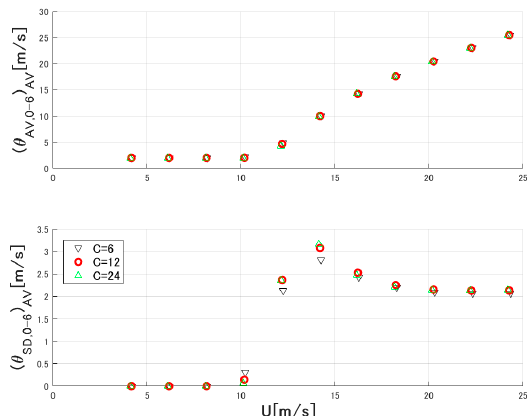
Figure 9. Mean and standard deviation of the pitch angle to the average centre hub wind speed.